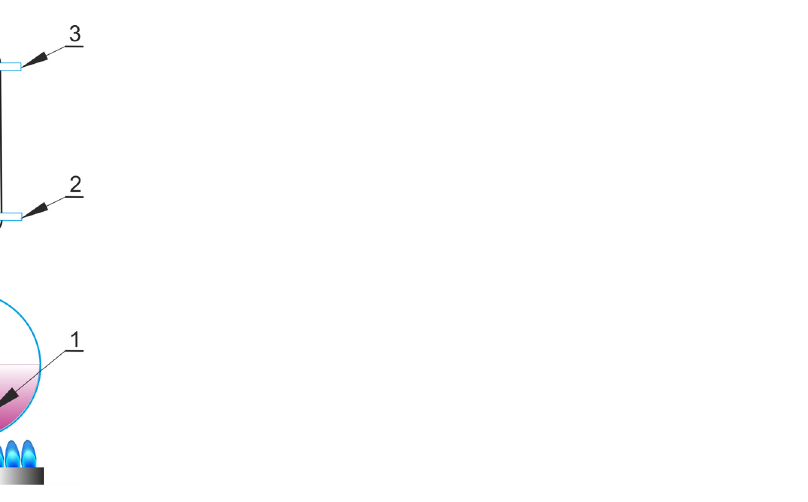
Table 3. Control parameters and values of the process.